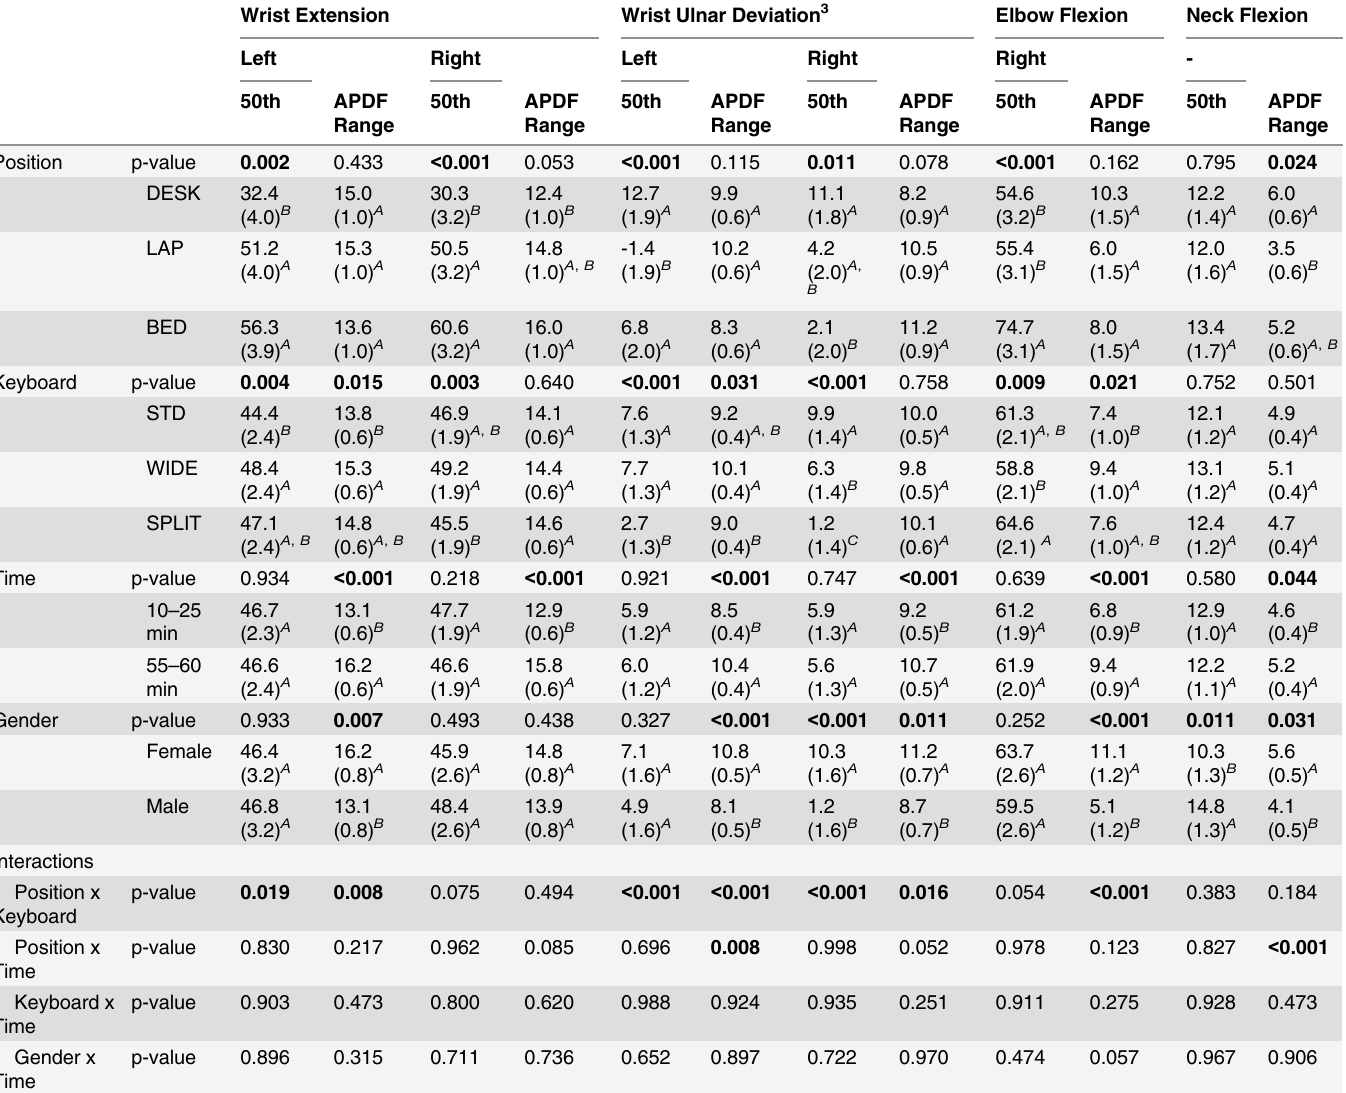
Table 2. Least-square mean (SE) of the postural parameters for rANOVA main effects Position, Keyboard, Time, Gender and p-values for the inter- actions 1 2 . Wrist